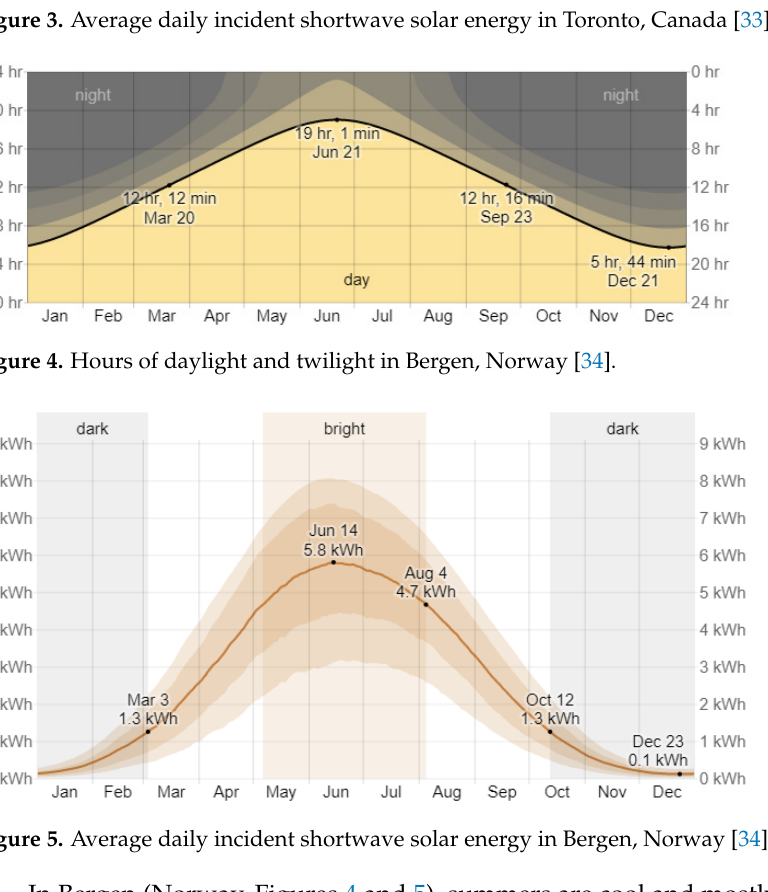
Figure 3. Average daily incident shortwave solar energy in Toronto, Canada [33].